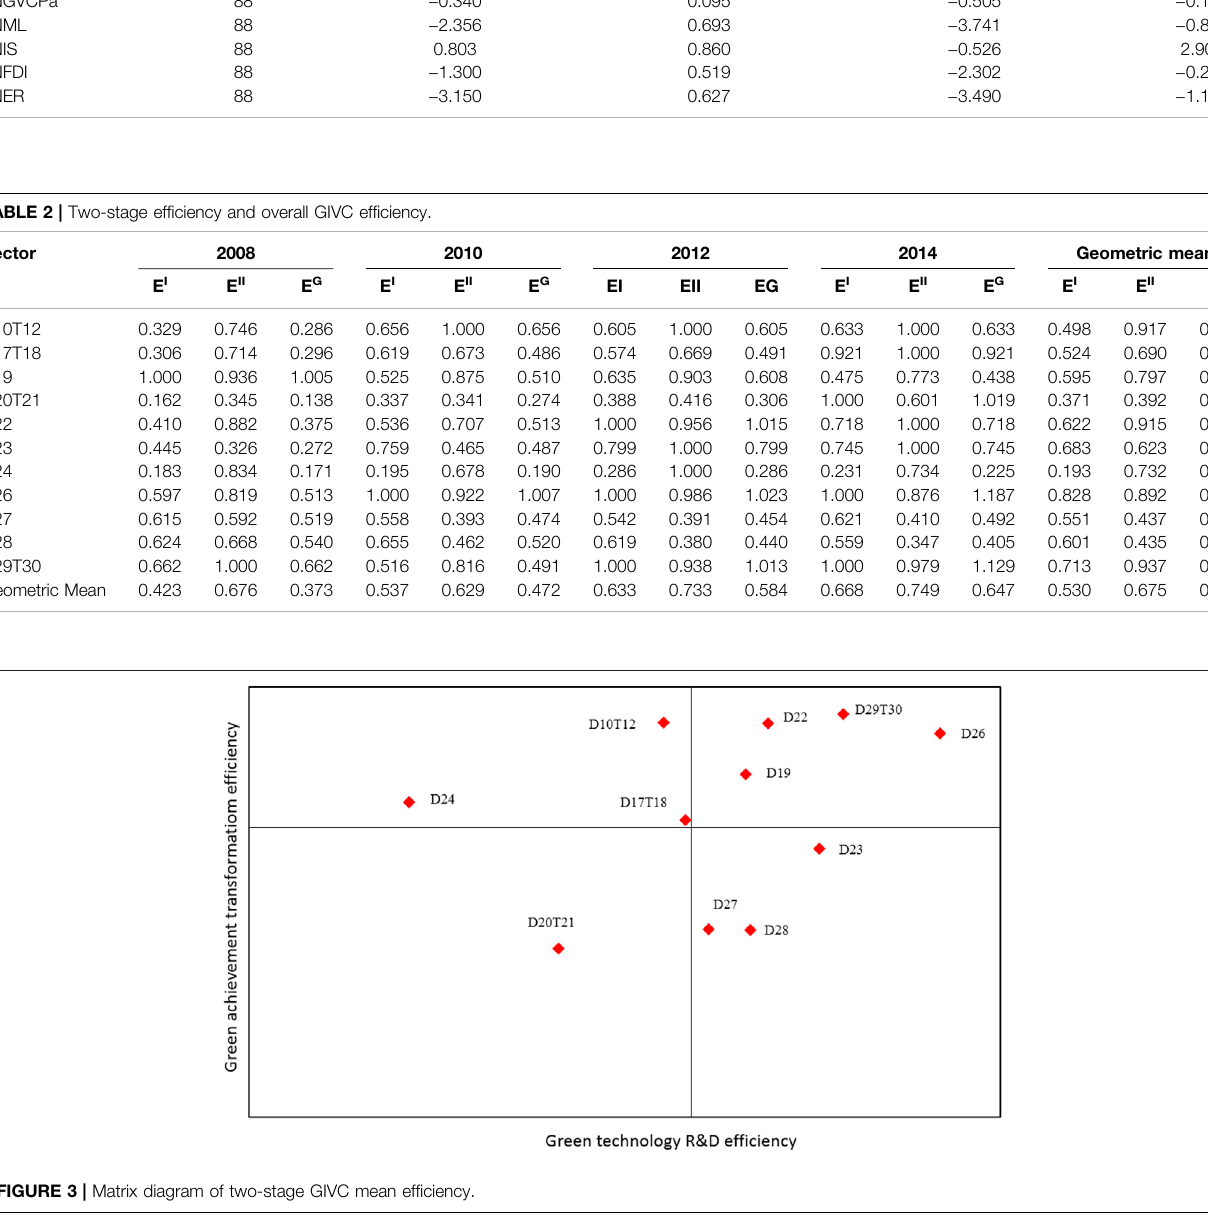
Frontiers in Environmental Science |